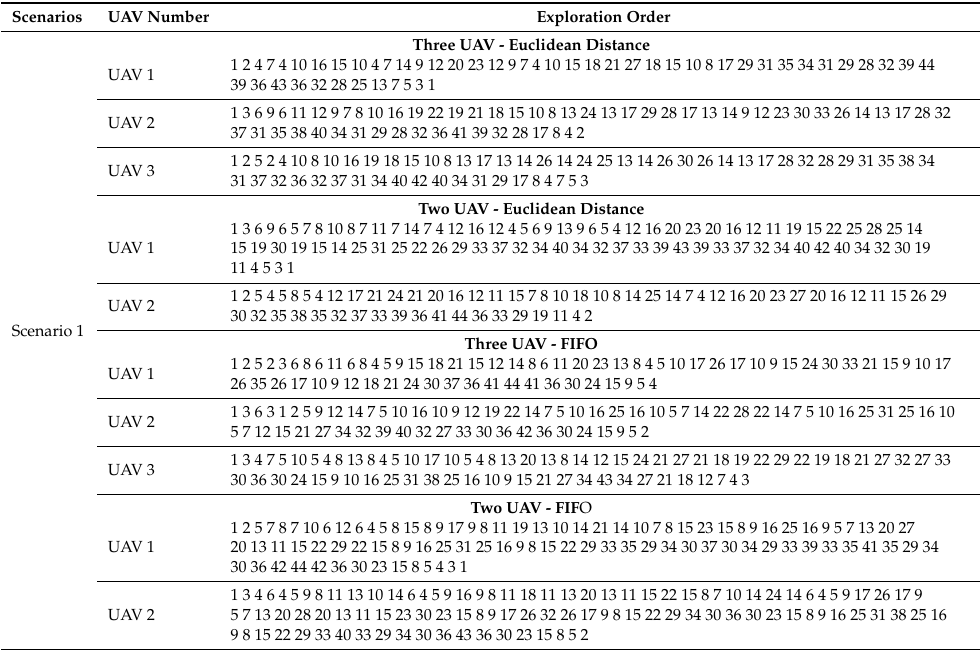
Table 6. Displacement